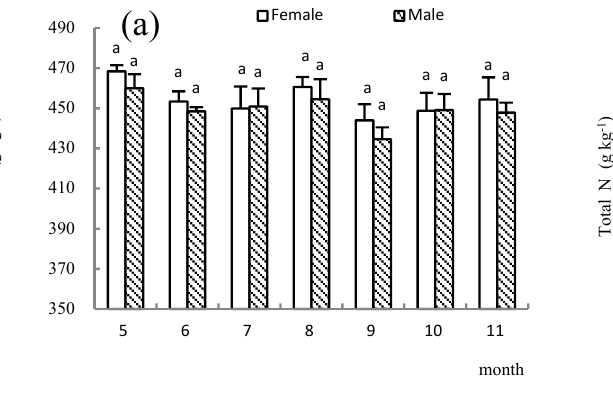
Figure 4. Monthly dynamic of C/N ( a ), C/P ( b ), N/P ( c ) ratios in different organs of male plants of F. velutina . Note: Means of different months not sharing the same letter indicated significant differ- ences at an alpha level of 0.05, according to an LSD test.